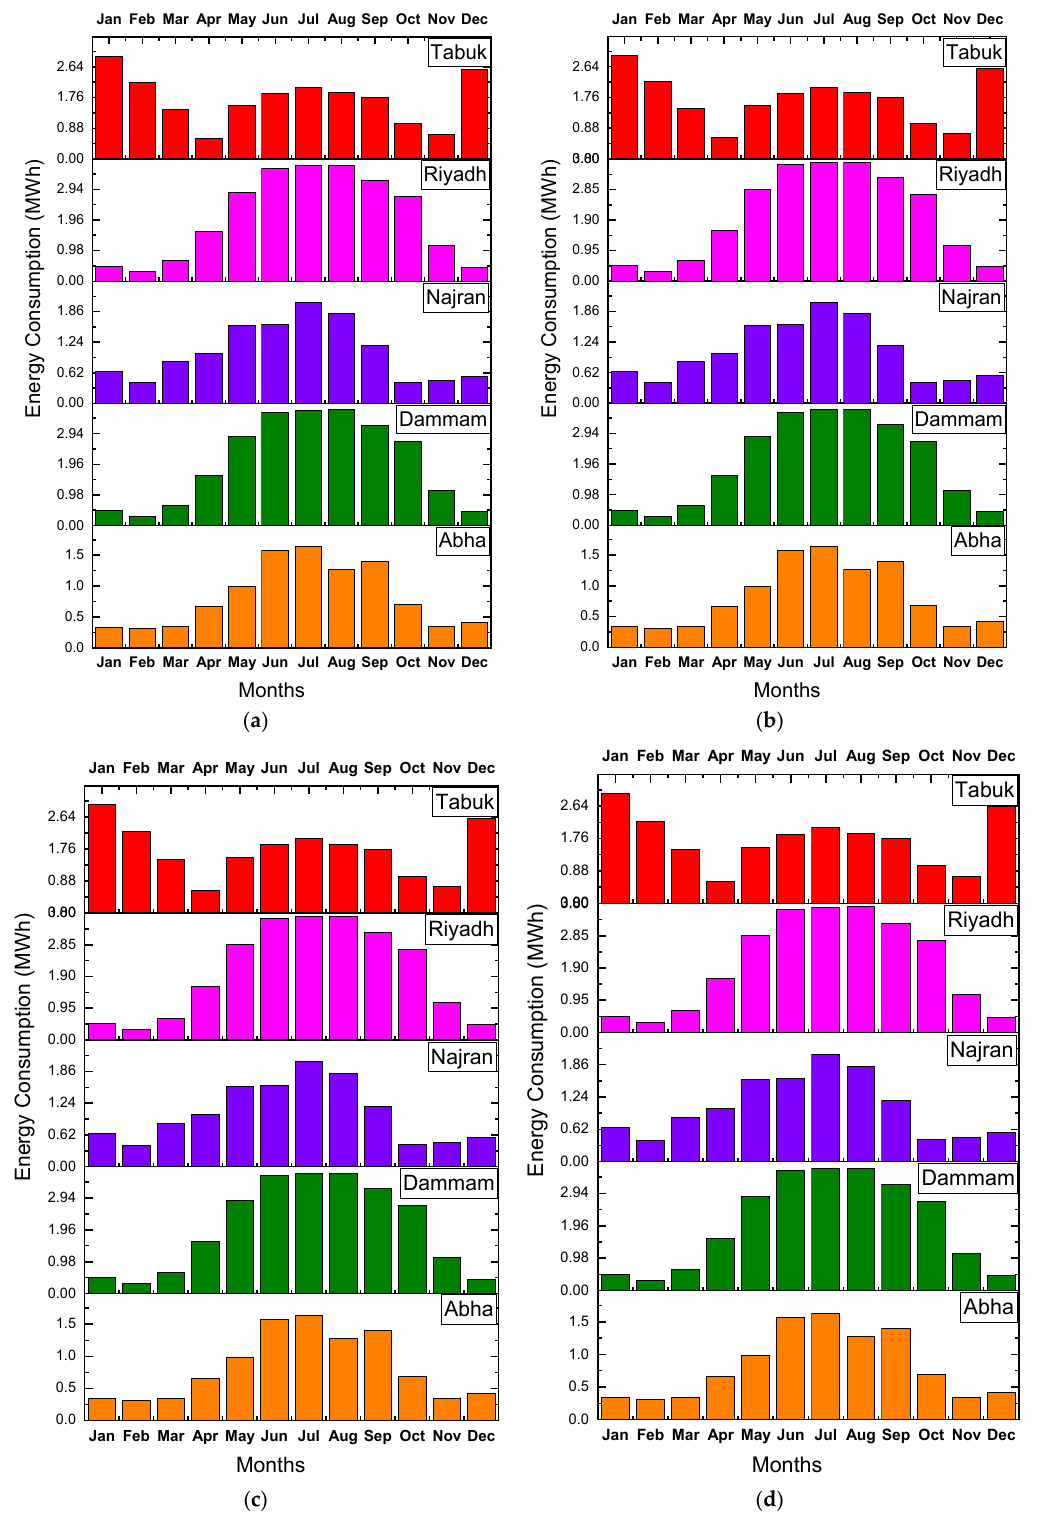
Figure 5. Comparison of monthly energy consumption by various insulation options, for different climates: ( a ) polyurethane board (PU) base case; ( b ) expanded polystyrene (ESP); ( c ) urea-formaldehyde foam (UFF); ( d ) glass wool (GW).